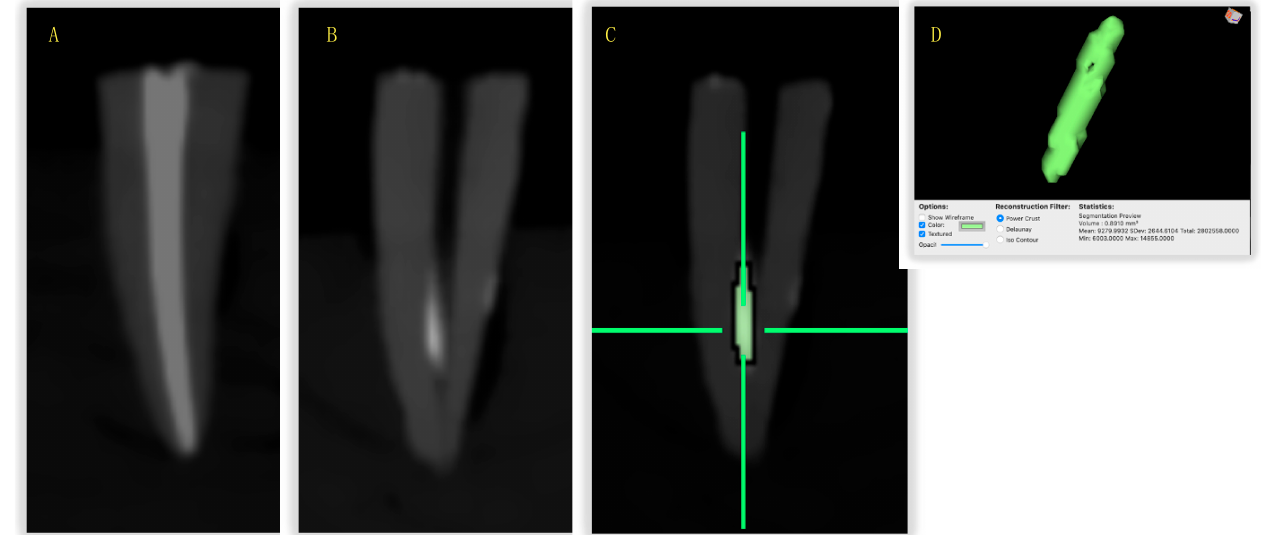
Figure 4. CBCT representation after root canal filling ( A ) and after SRCTs with RB #40 ( B ). Remnants are still present in the middle third of the root canal after SRCTs. Each CBCT representation was examined with HOROS software to measure the volume of filling material after SRCTs ( C ). The volume of remnants was identified using a semiautomatic segmentation based on the values of the grayscale (gray values for dentin, black values for the root canal, and white for filling material). The region of interest (ROI) was then determined and reconstructed in 3D to calculate the volume of remnants ( D